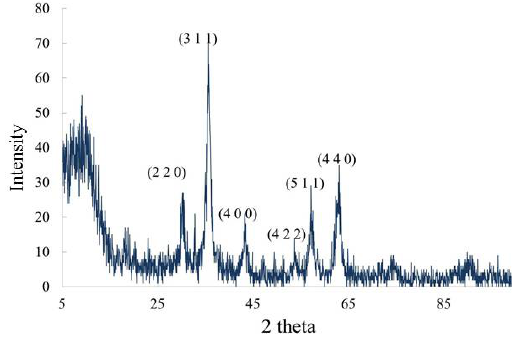
Fig. 5. XRD pattern of the β-CD modified Fe Fig. 5 XRD pattern of the β -CD modified Fe 3 O 4 nanoparticles synthesized.